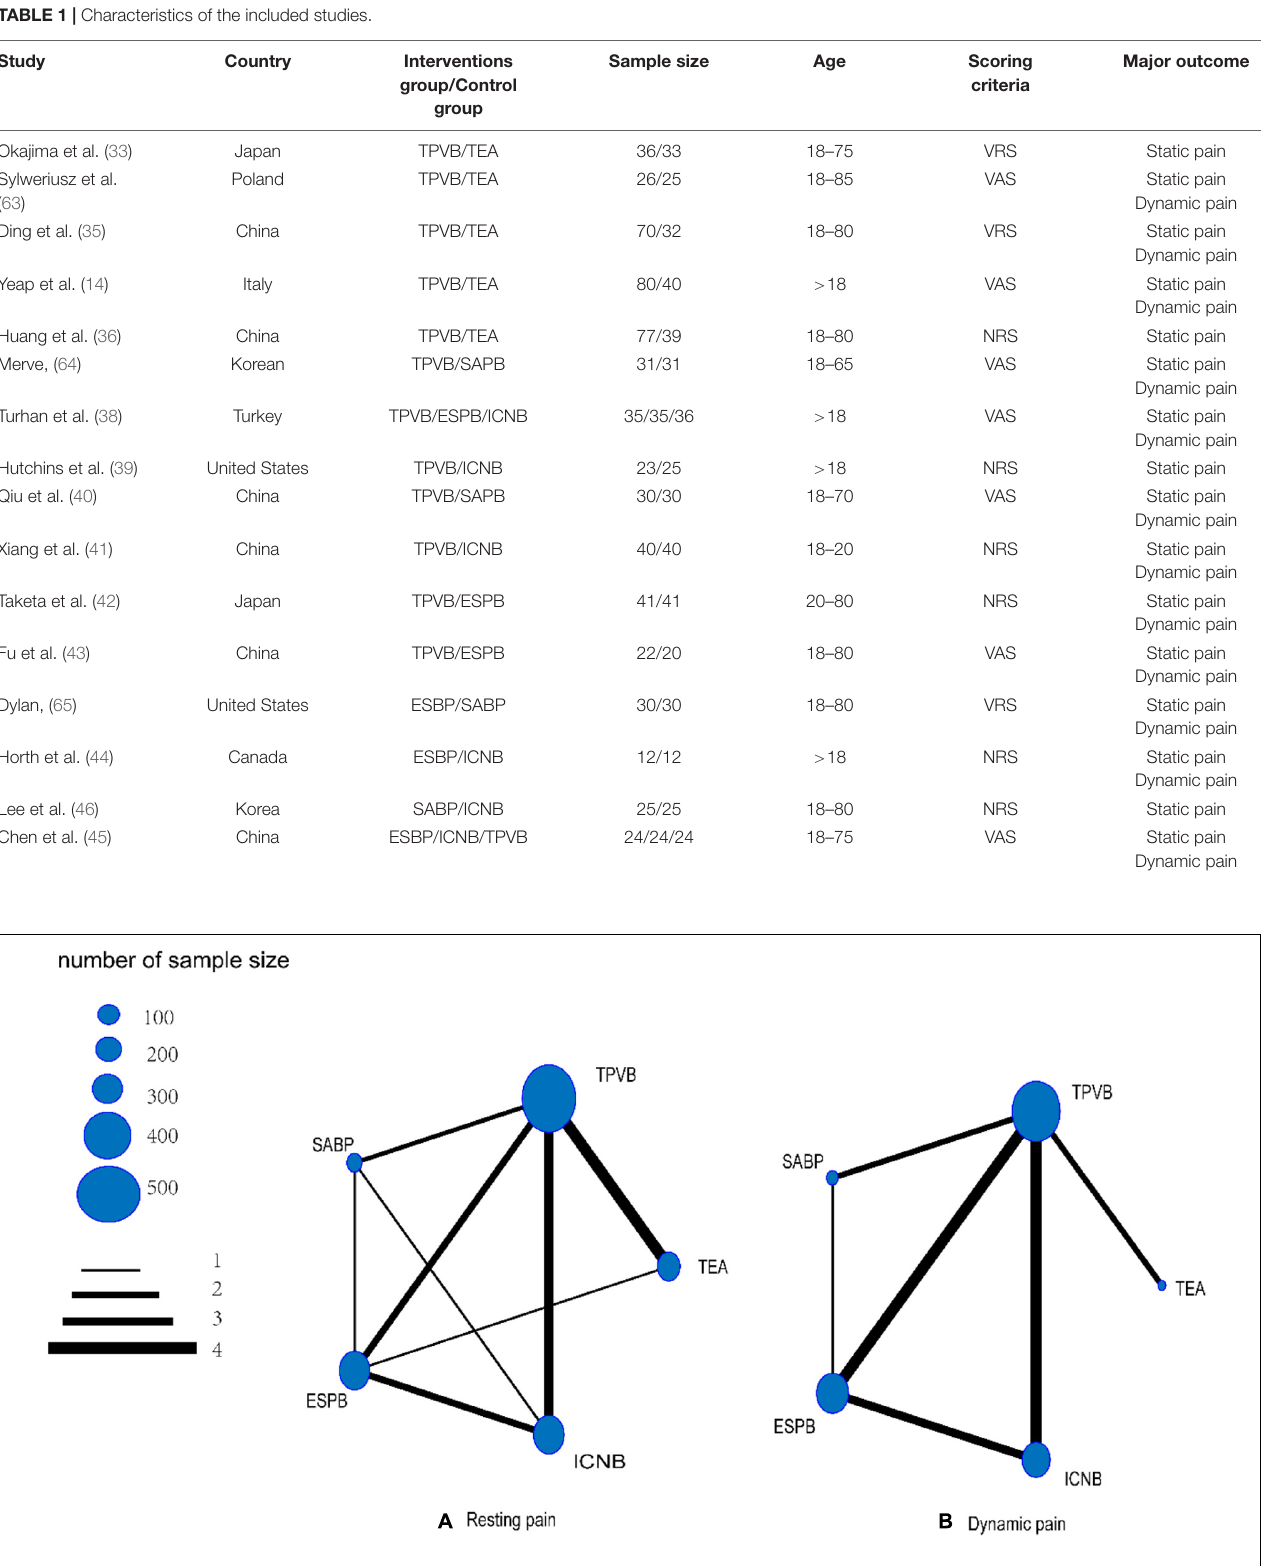
TABLE 1 | Characteristics of the included studies.